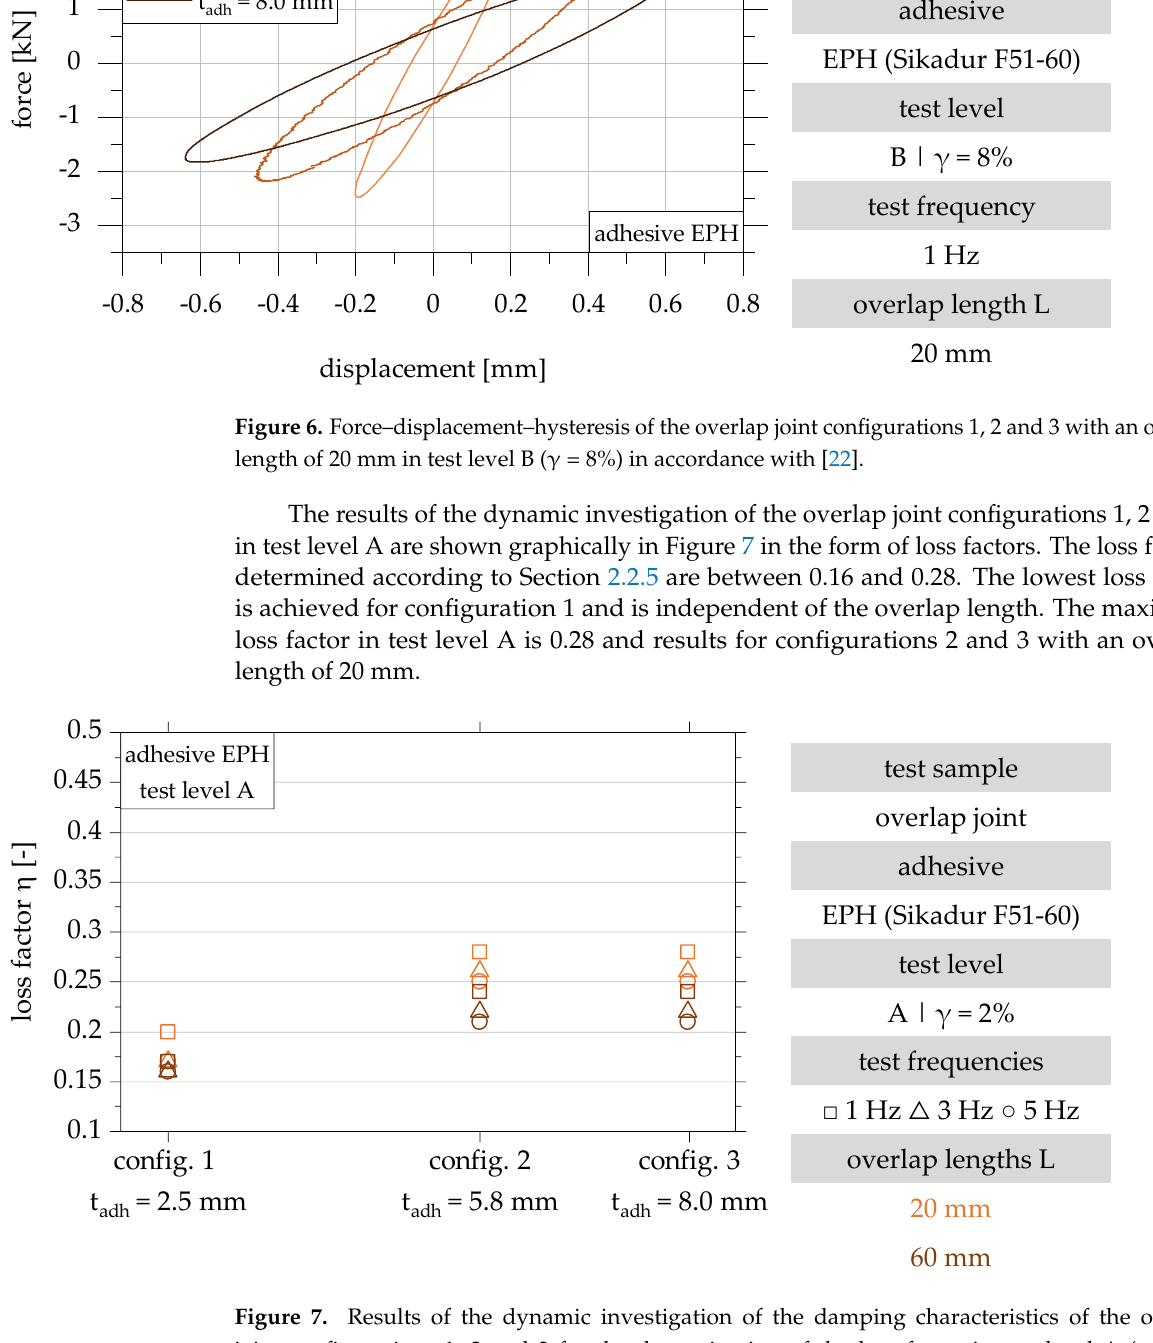
Figure 7. Results of the dynamic investigation of the damping characteristics of the overlap joint configurations 1, 2 and 3 for the determination of the loss factor in test level A ( γ = 2%) in accordance with [22].